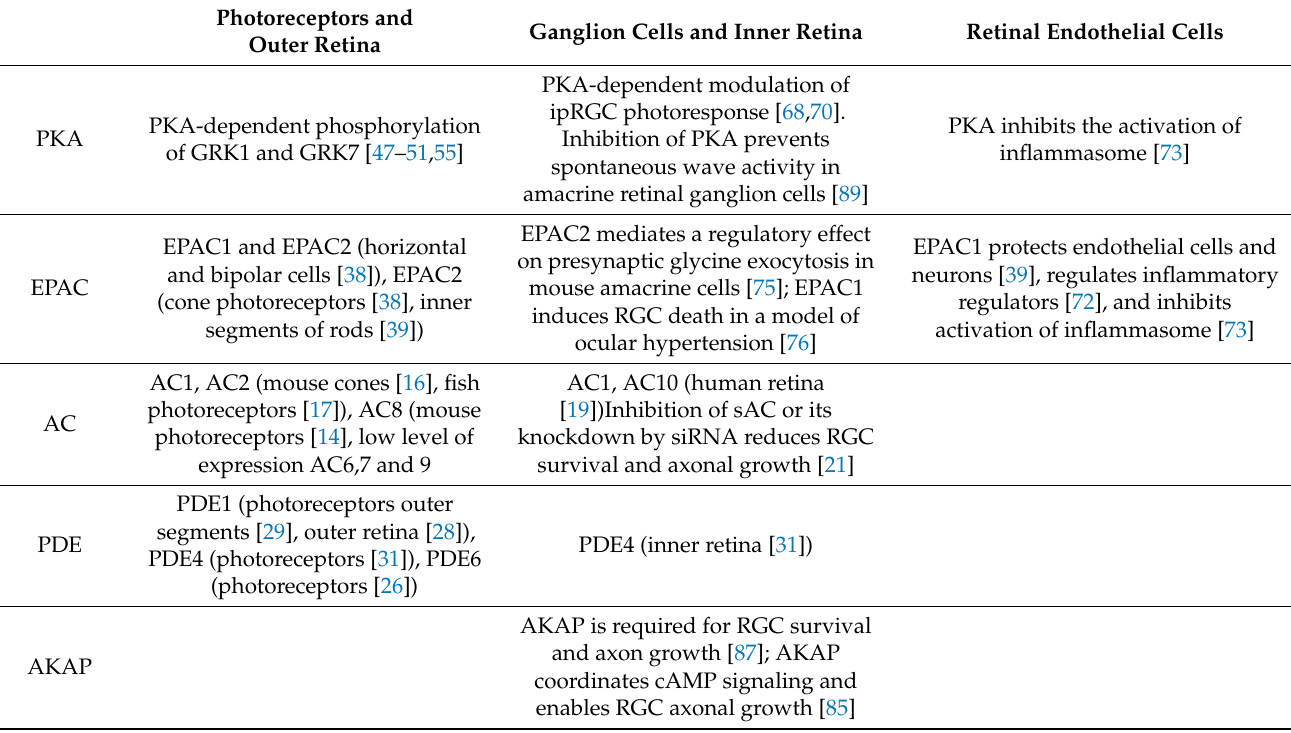
Table 1. The table summarizes the available data on the localization and proven function of the main components of the cAMP-dependent regulation in different compartments of the